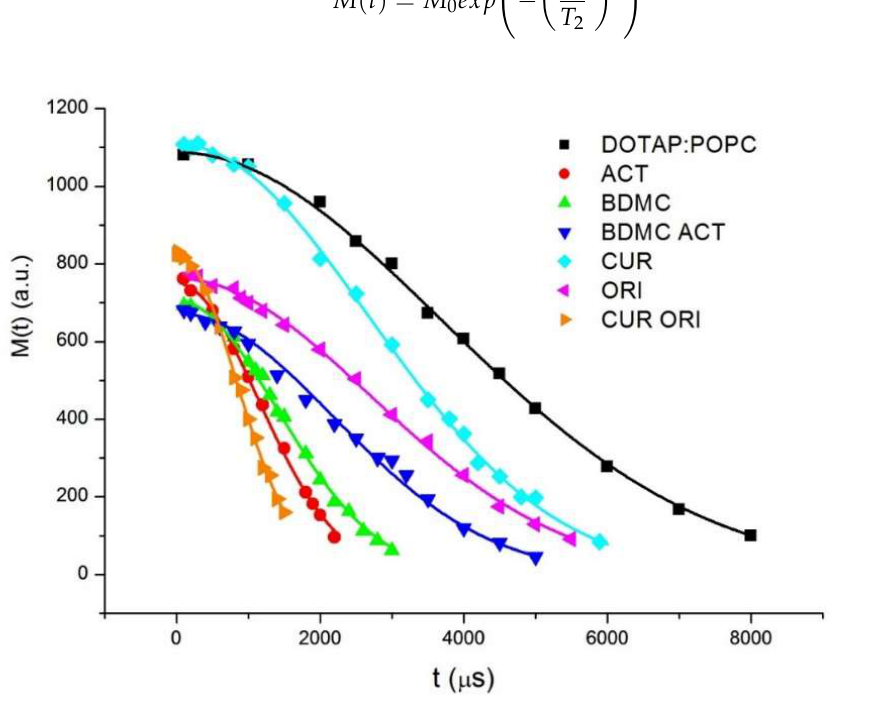
Figure 7. The decay of the magnetization obtained in the experiment for the measurement of the spin–spin relaxation time T 2 for all liposome samples.